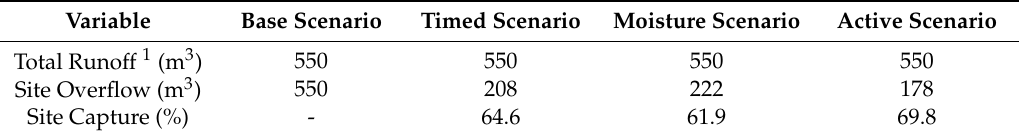
Table 5. Site Wet-Weather Performance Comparison (2004–2013)—Annual Averages.